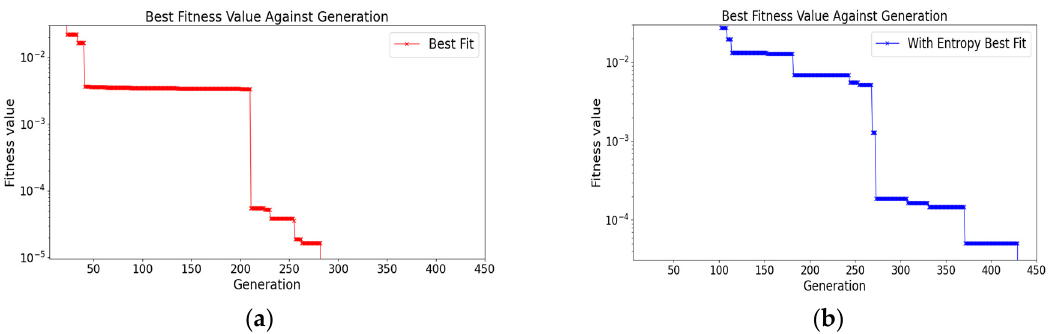
Figure 4. Figures of convergences of the solutions. ( a ) Convergence of the solution using the GA; ( b ) Convergence of the solution for a GA using